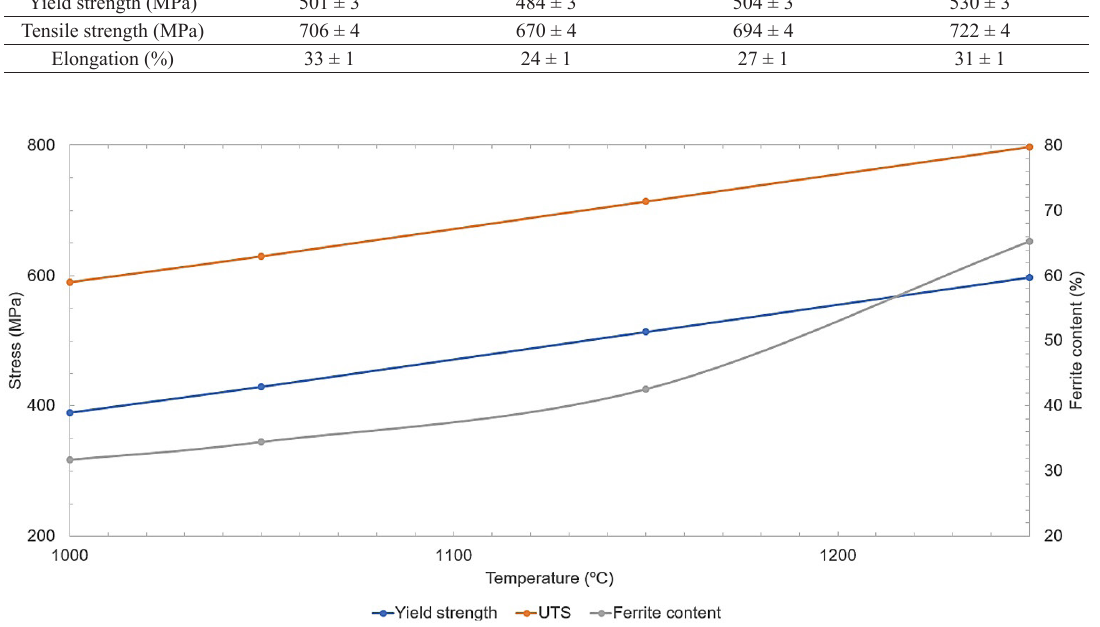
Table 3. Mechanical properties of the welded joints and base metal obtained from tensile testing. Mechanical